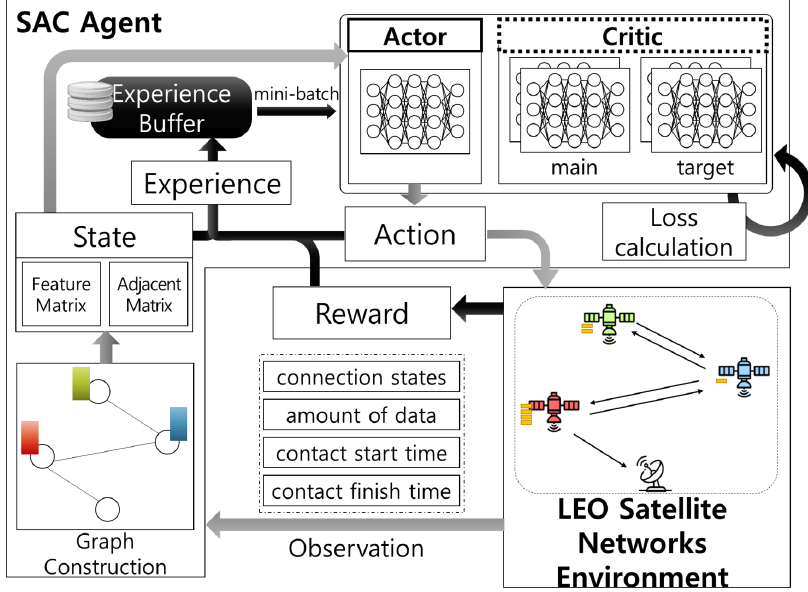
Figure 2. DRL-based cooperative downloading framework.